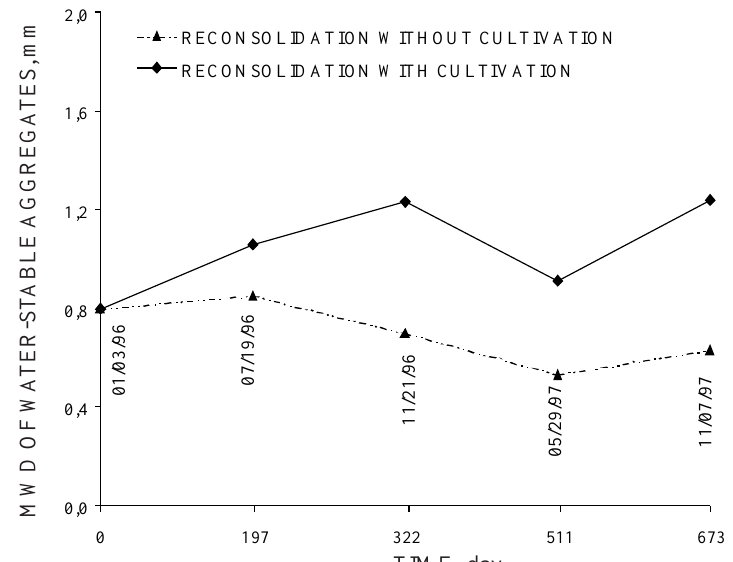
Figure 2. Size of water-stable aggregates (MWD) at a soil depth of 0-0.10 m as a function of time in the reconsolidating soil